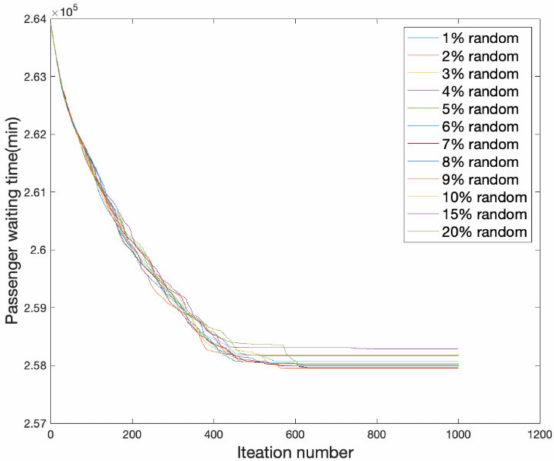
Figure 22. Results of robustness